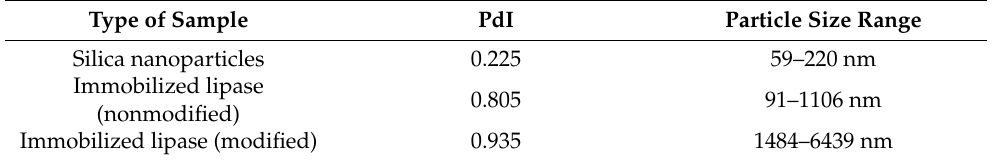
Table 2. Particle size distribution of the pure silica and biocatalyst with lipase immobilized by physical immobilization by the adsorption interactions and partially interfacial activation and mixed physical immobilization via interfacial activation and ion exchange on silica